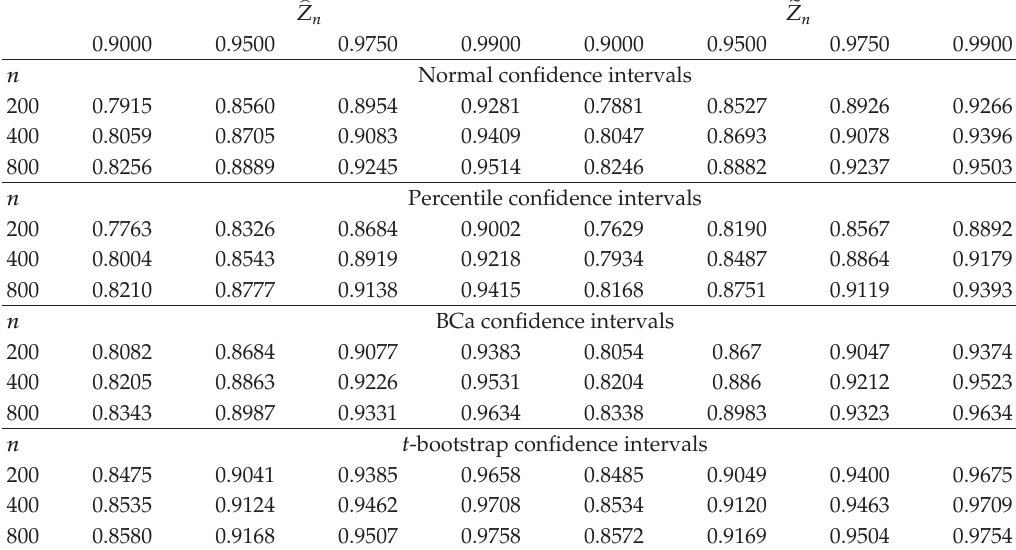
Table 1: Coverage proportions of confidence intervals from the Pareto parent distribution with x 0 (cid:7) 1 and θ (cid:7) 2 . 06 (cid:3) Z F (cid:7) 0 . 6 (cid:4)